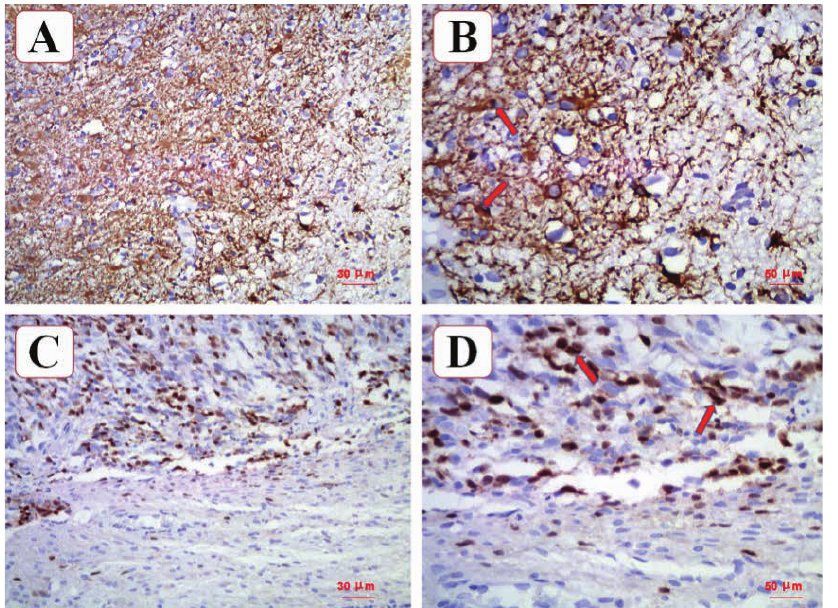
Figure 1: The fascin-1 protein expression in glioma tissues (A and B) and normal brain tissue (C and D). (A and C) ×20; (B and D) ×50. (A and B) Male, 57 years old; (C and D) Female, 49 years